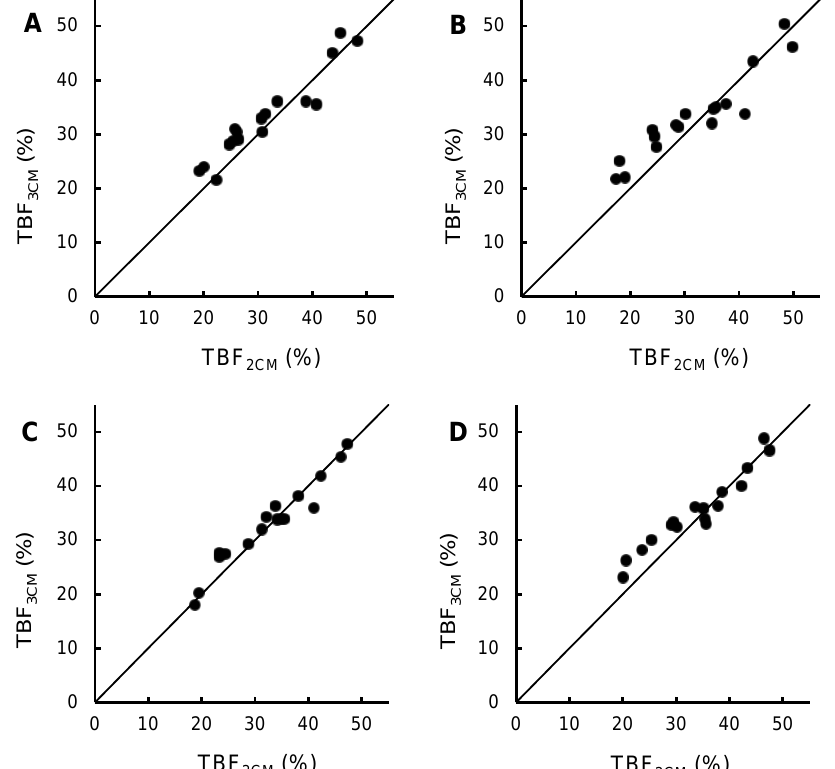
Figure 1. Total body fat, assessed using a three-component model ( y ) versus total body fat, assessed using a two-component model ( x ) in 17 healthy women [12] plotted around the line of identity. The fat-free mass density used in the two-component model is also given. ( A ) Before pregnancy, FFM density = 1.1 g/mL [6,13]; ( B ) Gestational week 14, FFM density = 1.099 g/mL [2]; ( C ) Gestational week 32, FFM density = 1.092 g/mL [2]; ( D ) 2 weeks postpartum , FFM density = 1.094 g/mL [5]. FFM, fat-free mass; TBF 3CM , total body fat assessed using a three-component model; TBF 2CM , total body fat, assessed using a two-component